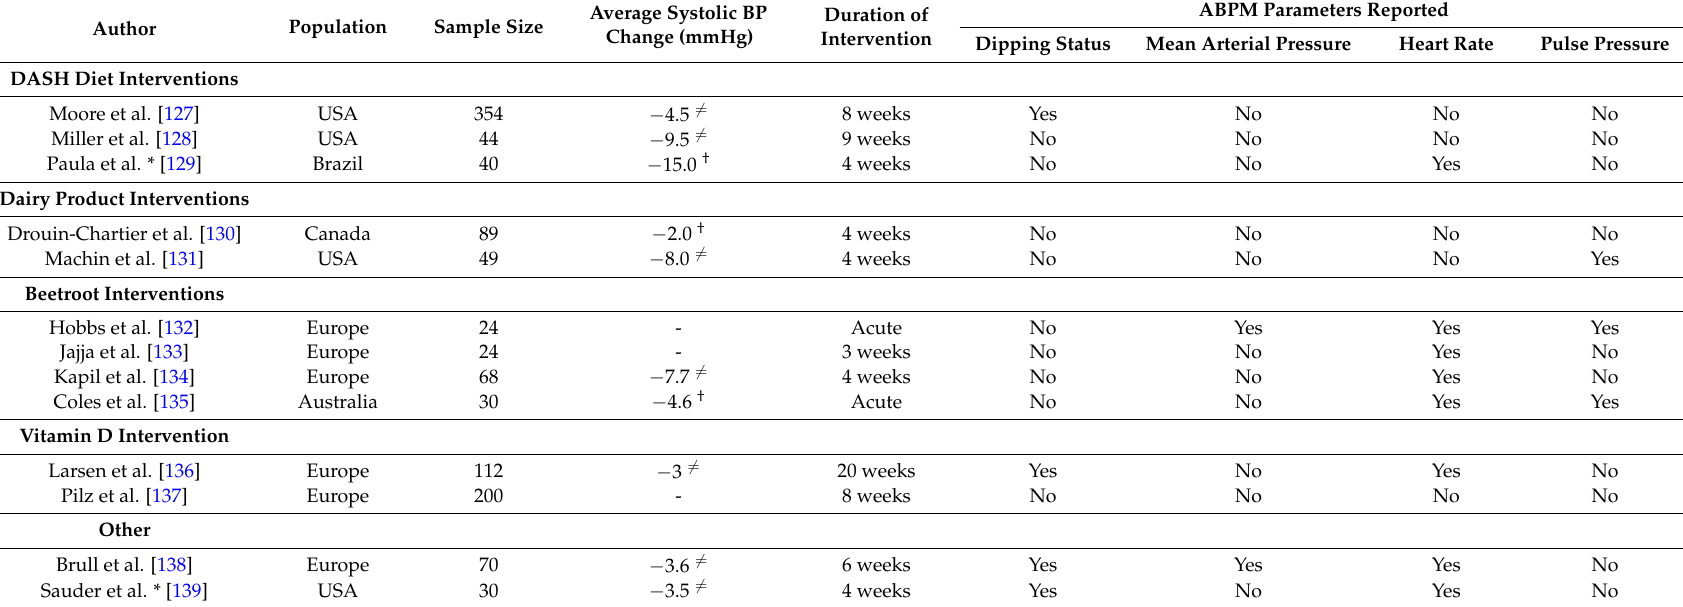
Table 3. Nutritional studies that report blood pressure response using ABPM in randomised controlled